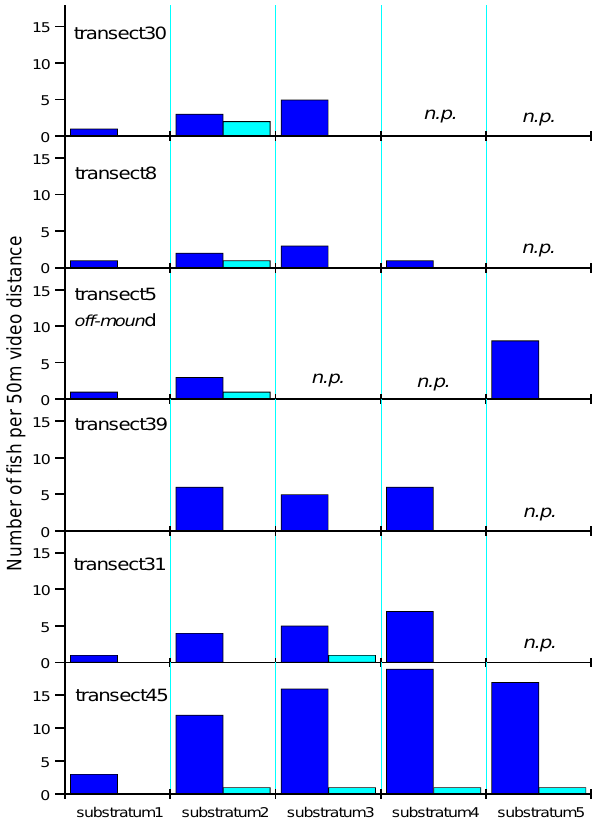
Fig. 7. Average fish abundance as counted for each 50m section along the video transects for each substratum. For explanation of the substrata numbers see Fig. 5.